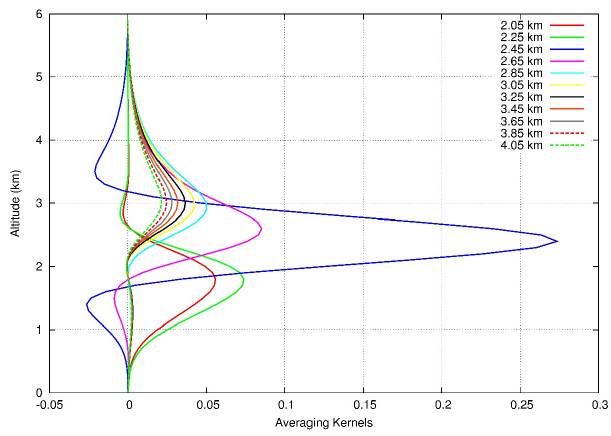
Figure 2. Example of NO 2 averaging kernels obtained in our profile retrieval, corresponding to 8 May 2013 at